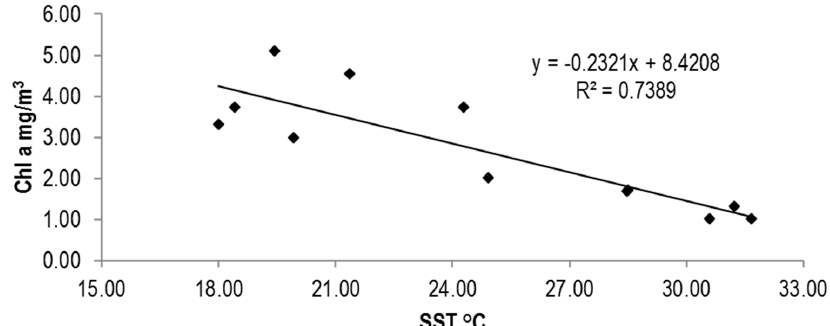
Figure 8. Relationship of sea surface temperature vs. chlorophyll a in the central and southern coastal region of Sonora and adjacent deep zone in the Gulf of California.